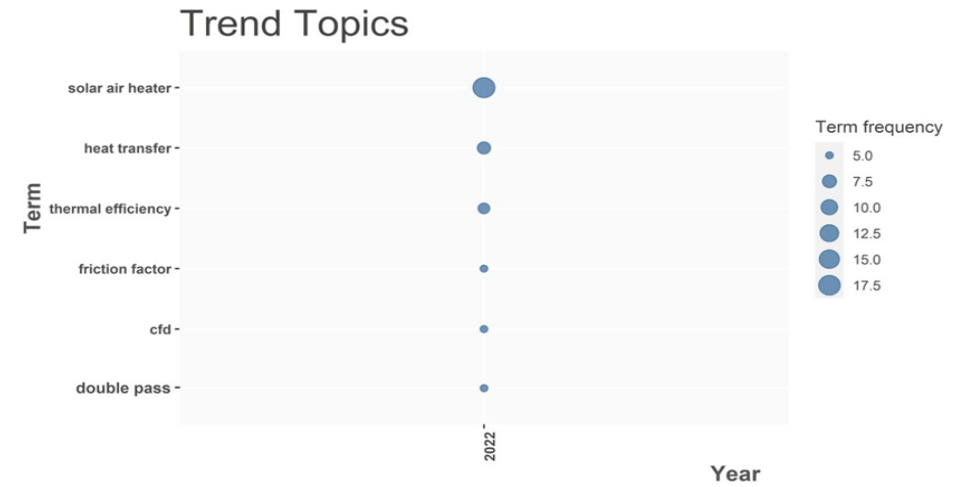
Figure 13. Solar air heaters trends during the period 1 January – 6 February 2022.